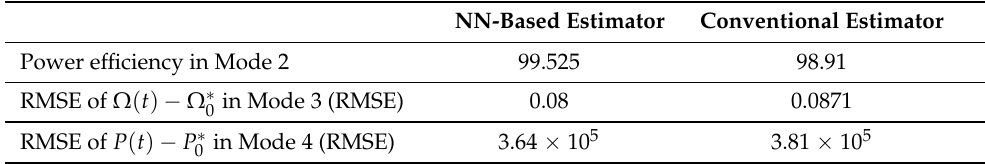
Table 2. Control performance in each